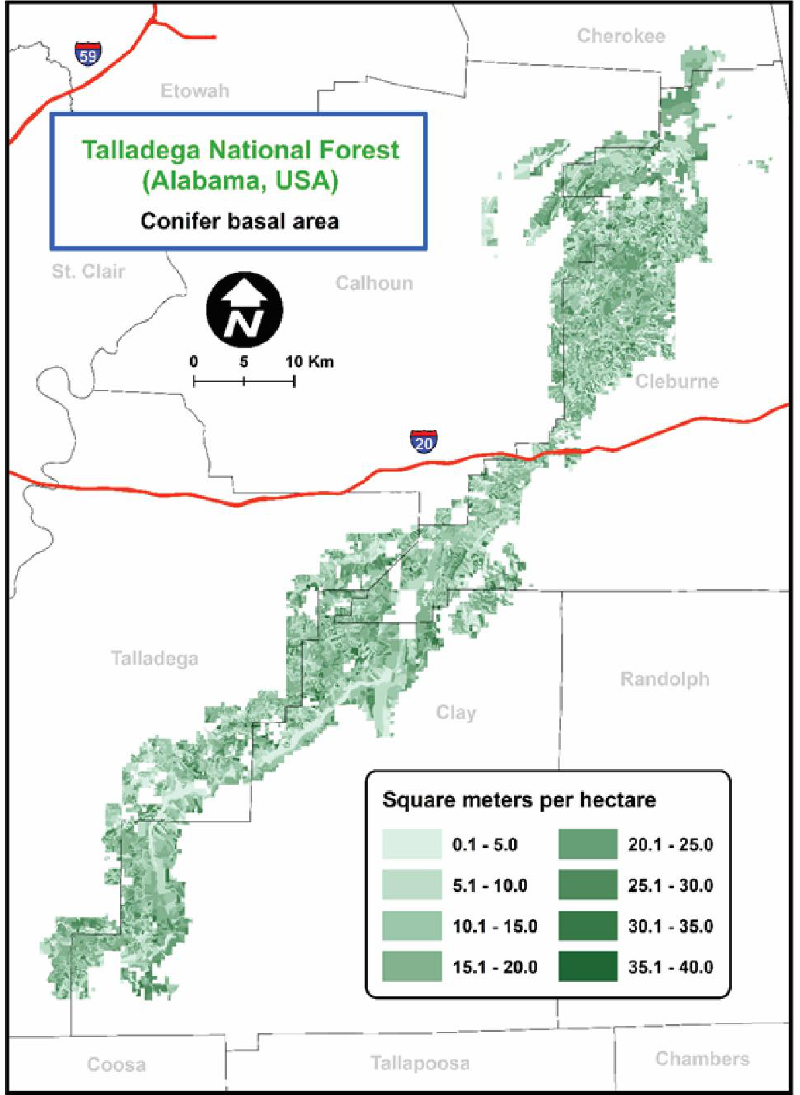
Figure 3. Estimated pine basal area (m 2 ) per hectare in the Talladega National Forest, Alabama, USA.